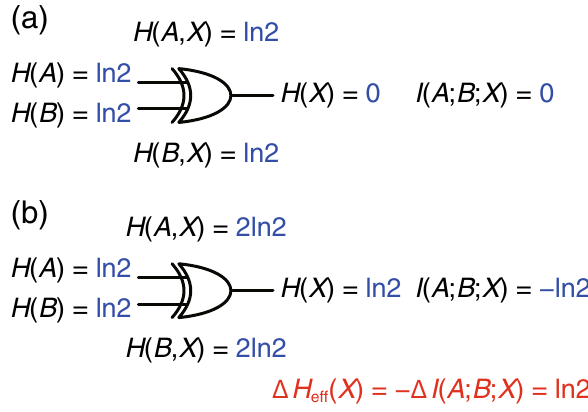
Figure 1. Logical entropy and mutual information regarding an XOR gate. ( a ) Initial state, where the output X is not generated. ( b ) Final state, where X (a random bit) is generated by producing mutual information I ( A ; B ; X ).